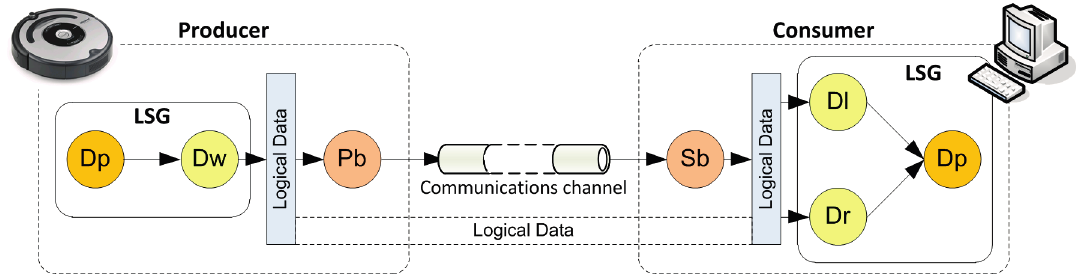
Figure 6. Elements involved in the communication between the robot and